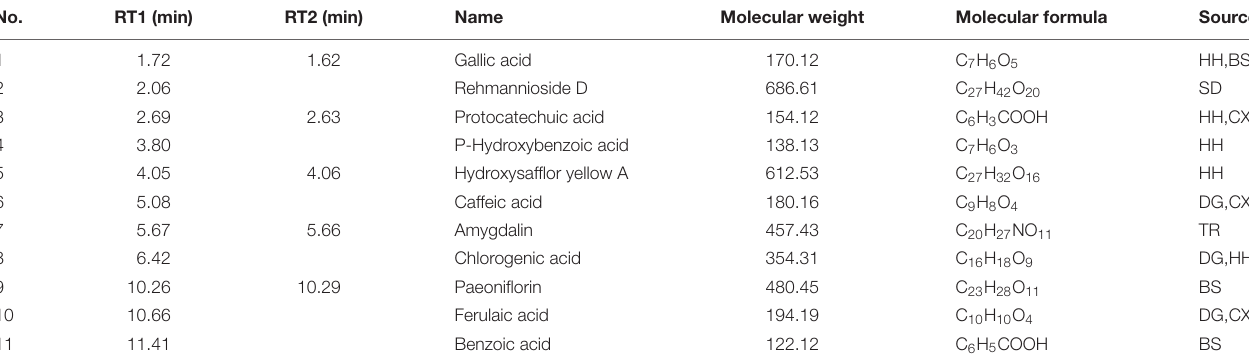
TABLE 1 | Analysis of THSWD by UPLC-TOF-MS.